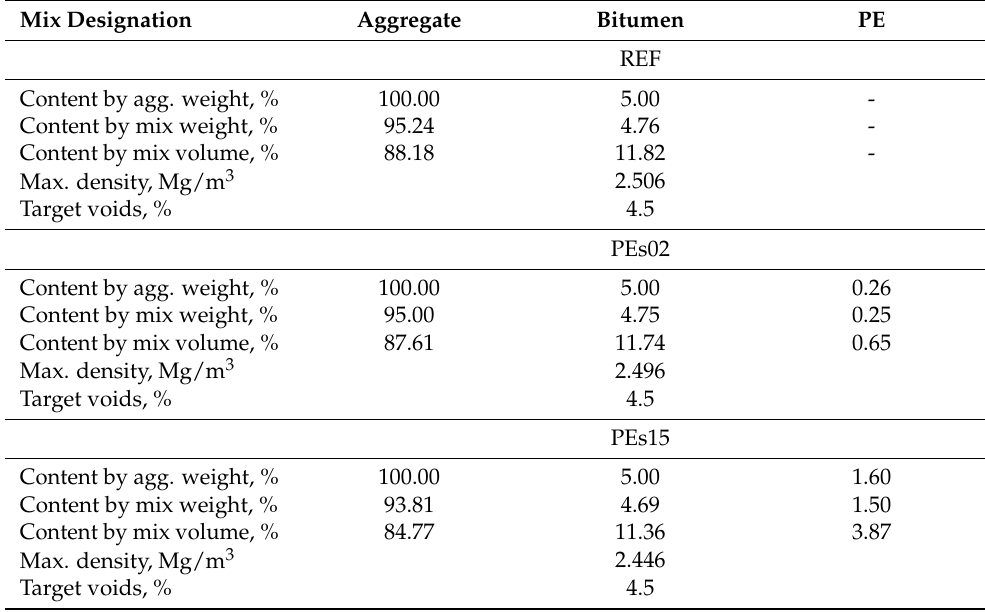
Table 5. The mix design: the proportions and characteristics of the produced